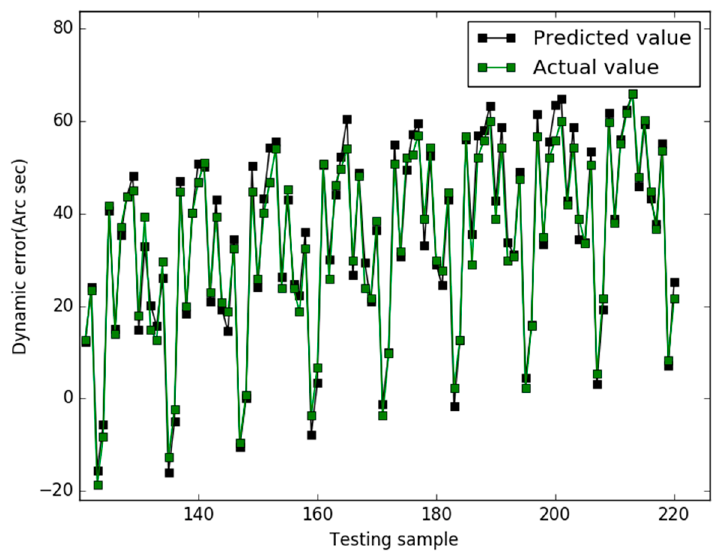
Figure 3. Predicted results of the GSO-SVM (case 1).